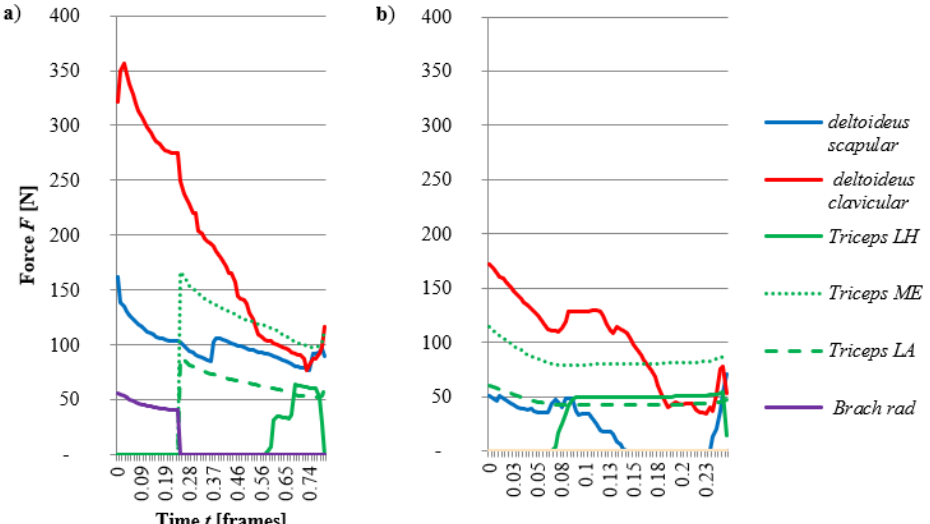
Figure 10. Simulation of movement and human muscle forces when propelling a wheelchair with the Wheelchair Push-rim Drive (WPD).